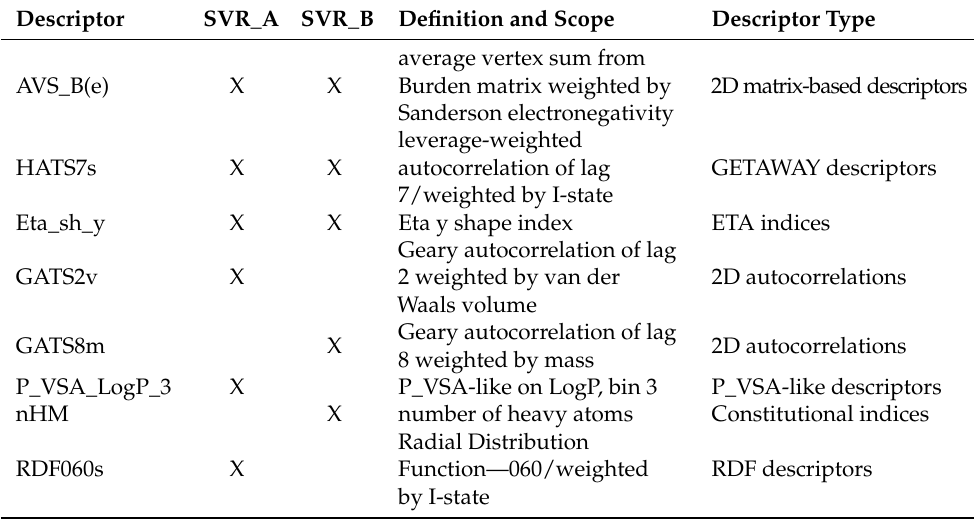
Table 3. Descriptors involved in each SVR model and the corresponding definition.